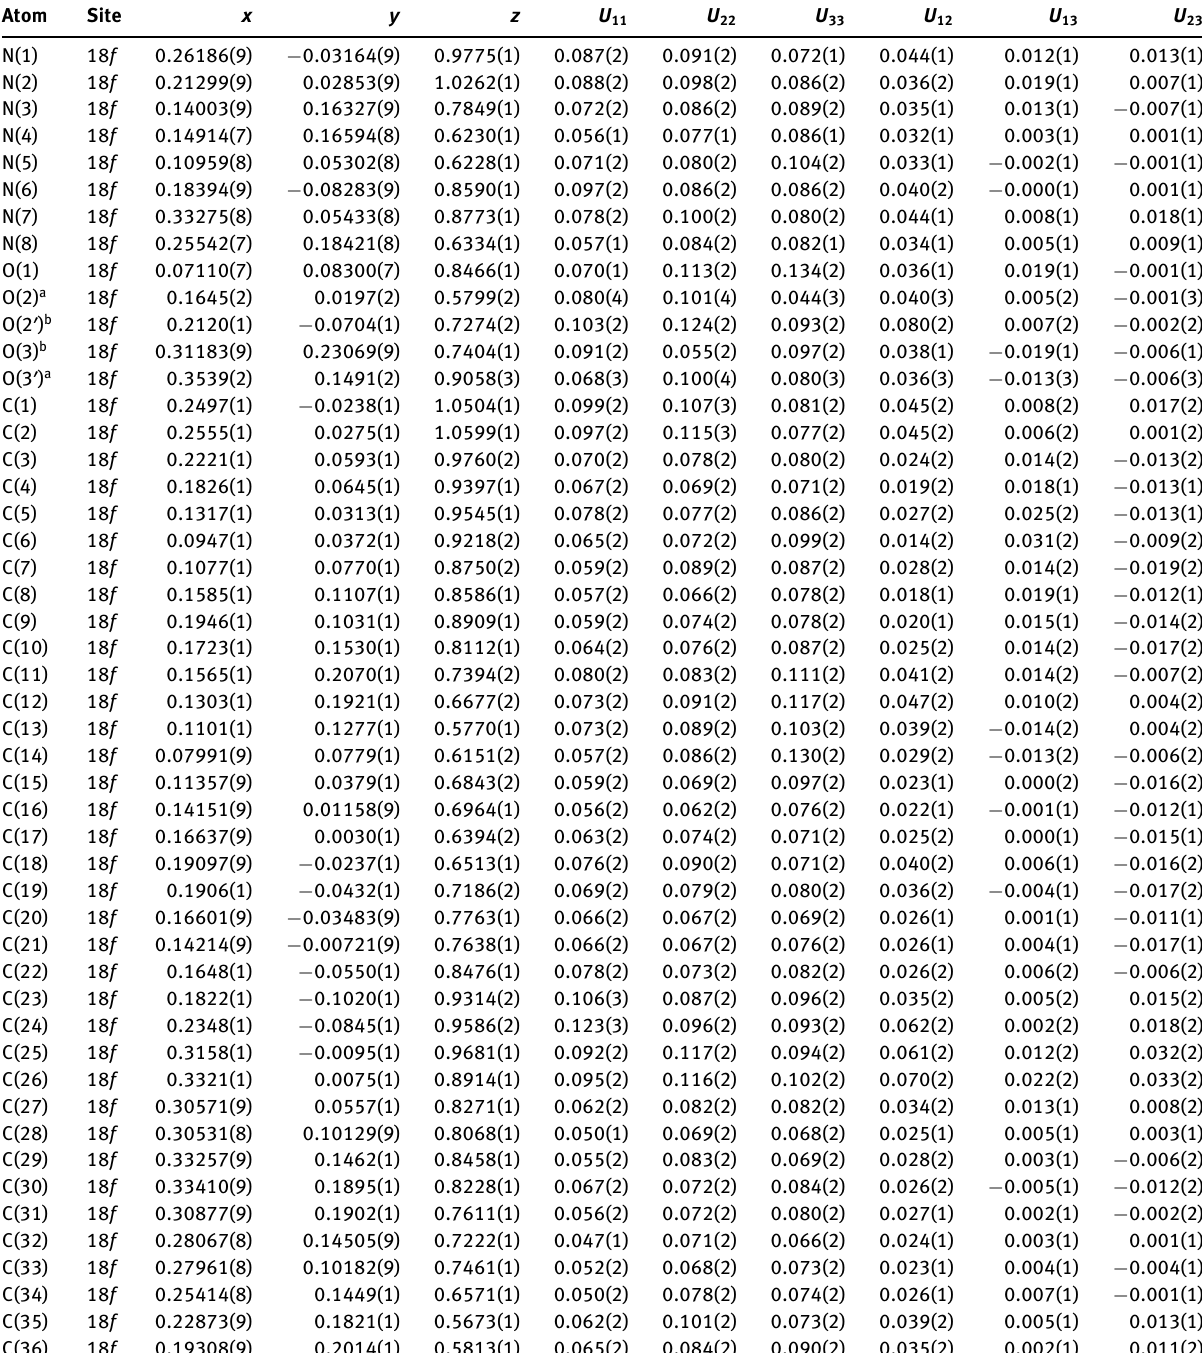
Table 3: Atomic displacement parameters (Å 2